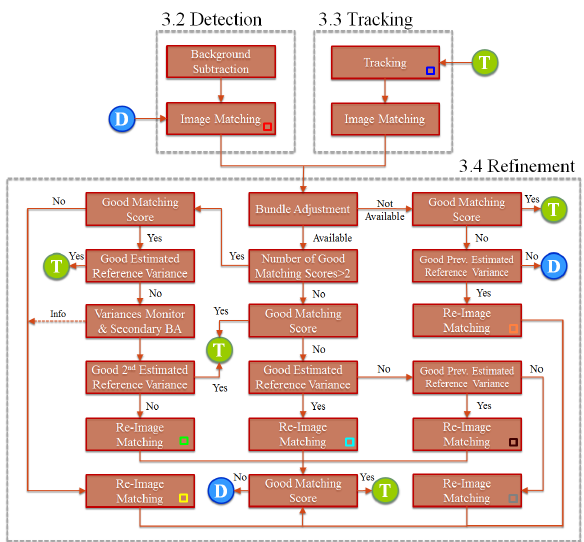
Figure 4. The proposed workflow of a